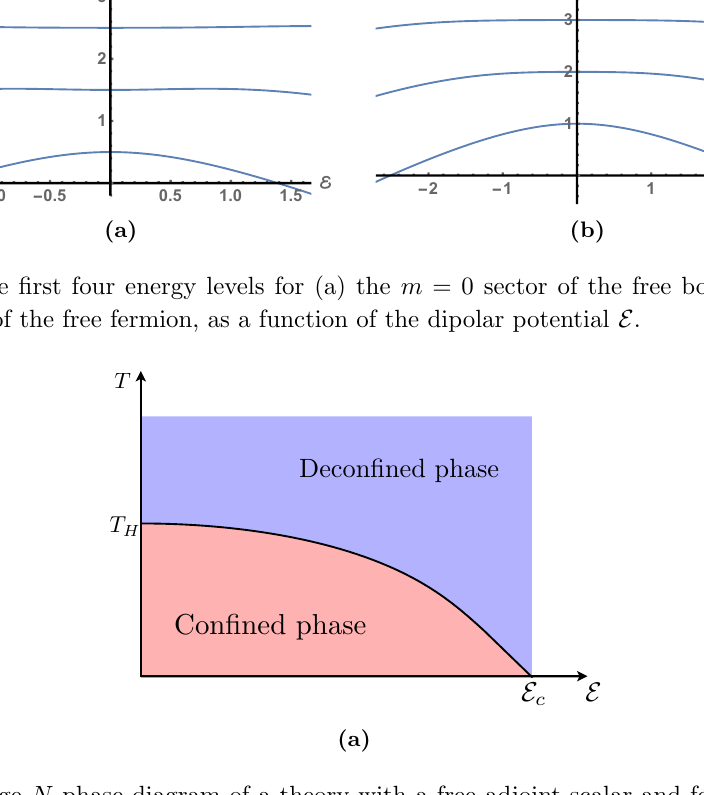
Figure 20. Large N phase diagram of a theory with a free adjoint scalar and fermion (cid:12)eld. The Hagedorn temperature decreases with the dipolar potential